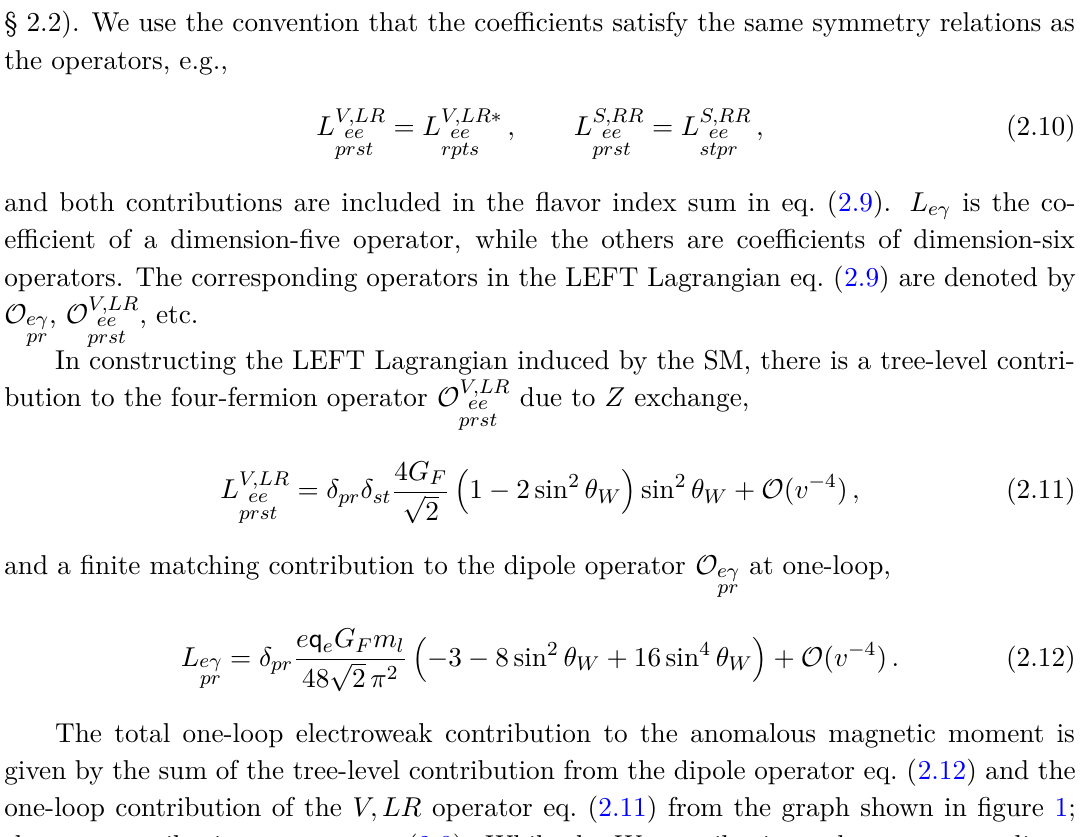
Figure 1 . One-loop contribution to the dipole moment from four-fermion